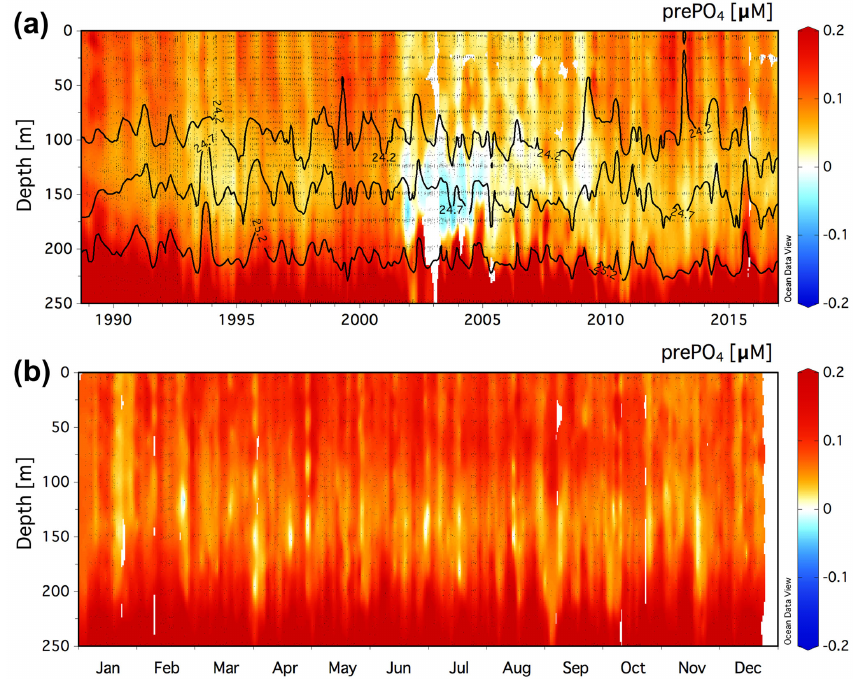
Figure 3. (a) Climatology of the residual prePO 4 tracer [µM] in the upper 250m at Station ALOHA (22.75 ◦ N, 158 ◦ W) for a value of r POM = 10 . 6. Black contour lines show neutral density, γ n = 24 . 2, 24.7, and 25.2. (b) The monthly averaged residual prePO 4 [µM] climatology for all data in the years 1989–2016.